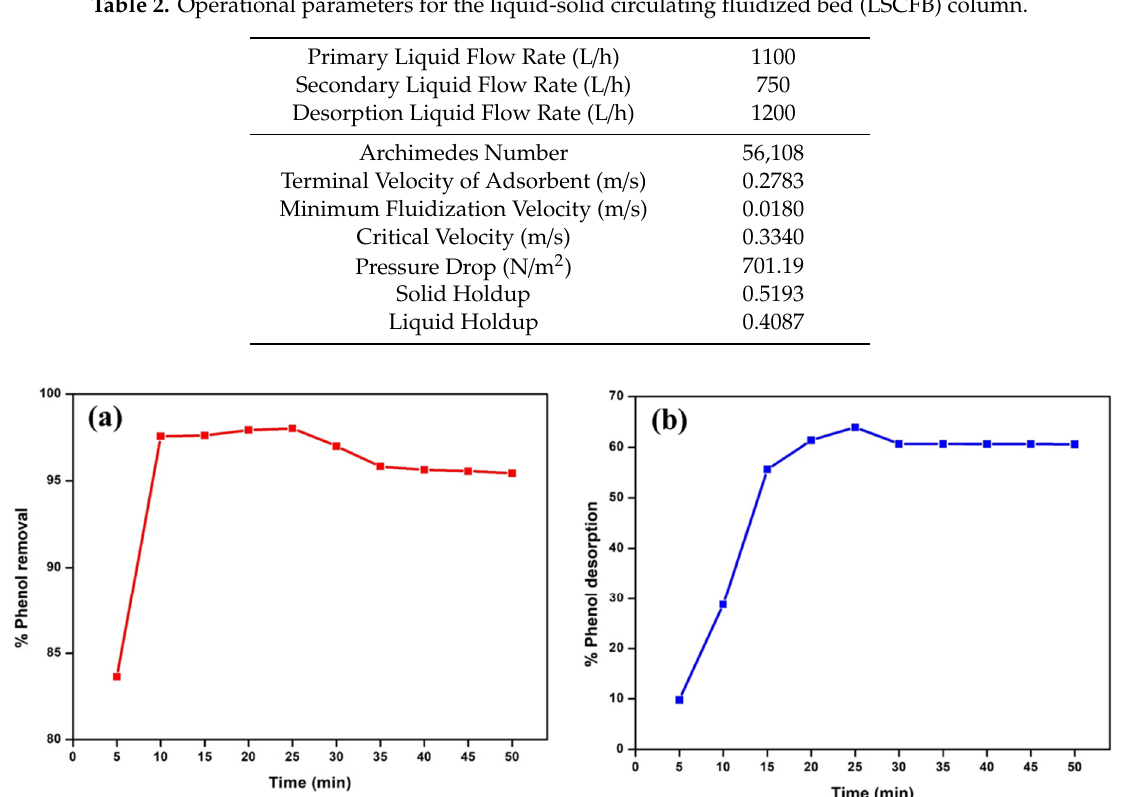
Figure 5. ( a ) The % phenol removal vs. time in an LSCFB; and ( b ) % phenol desorption vs. time in an LSCFB.